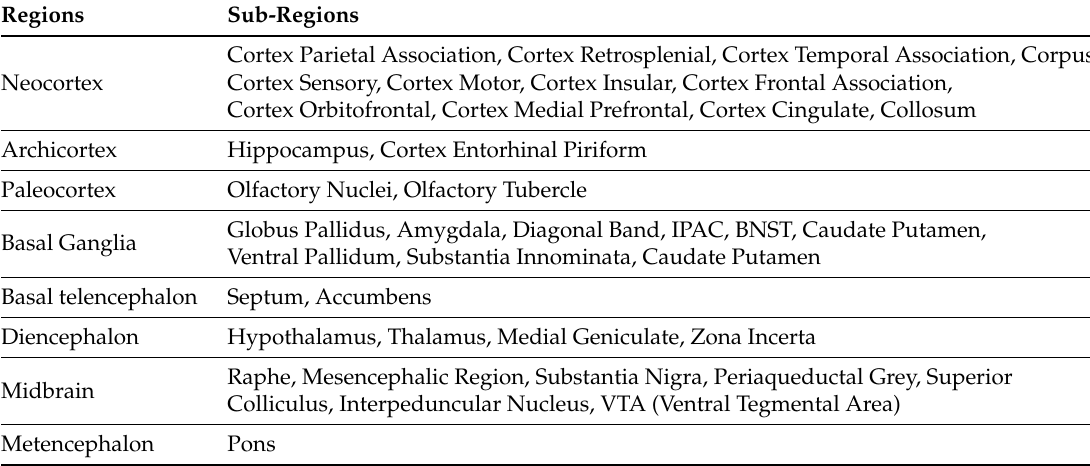
Table 1. Regions clustering.